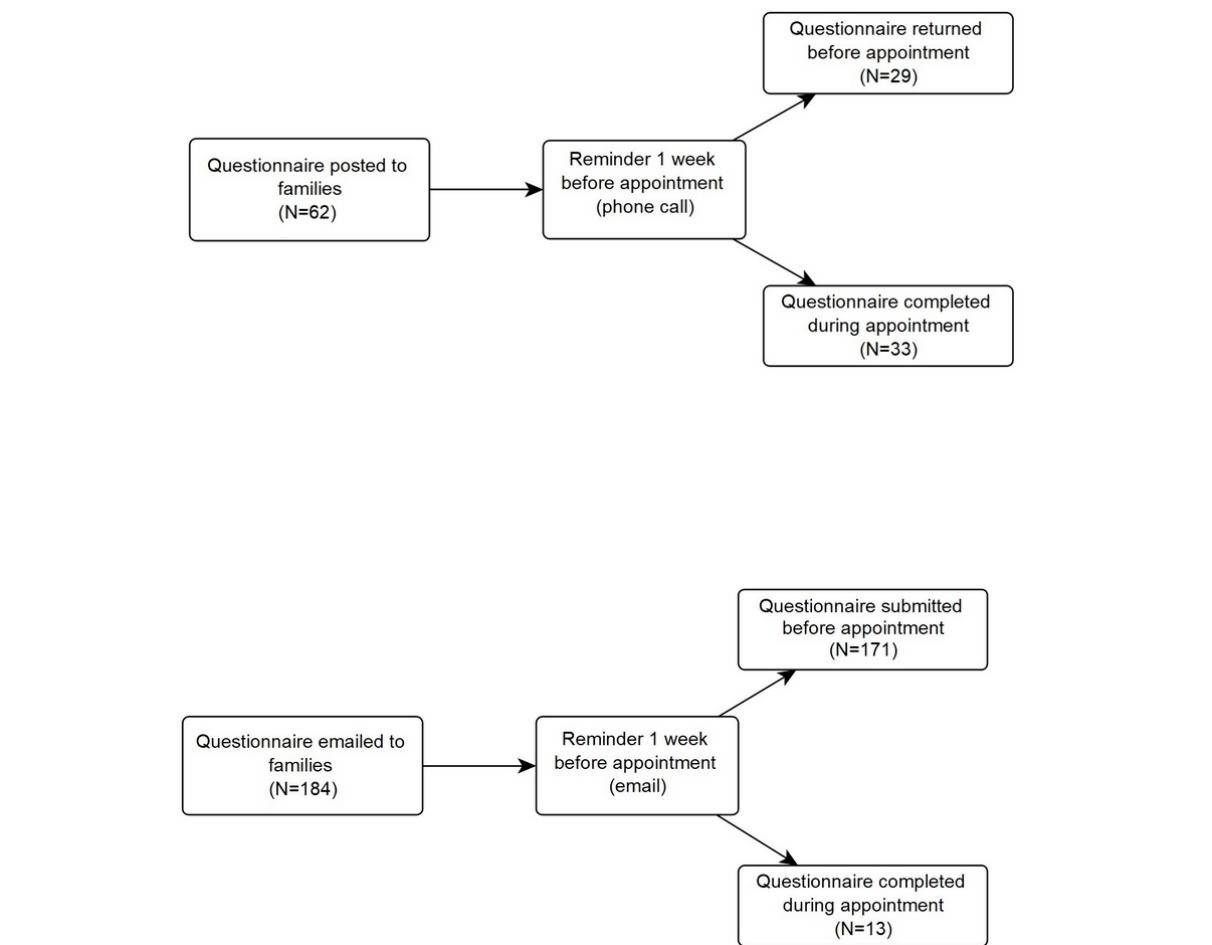
Figure 1. Flow chart of procedures for questionnaire completion modes and response rates for each mode. Numbers in parentheses describe the response rate for each